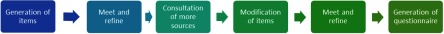
Stages of iterative refinement for questionnaire development